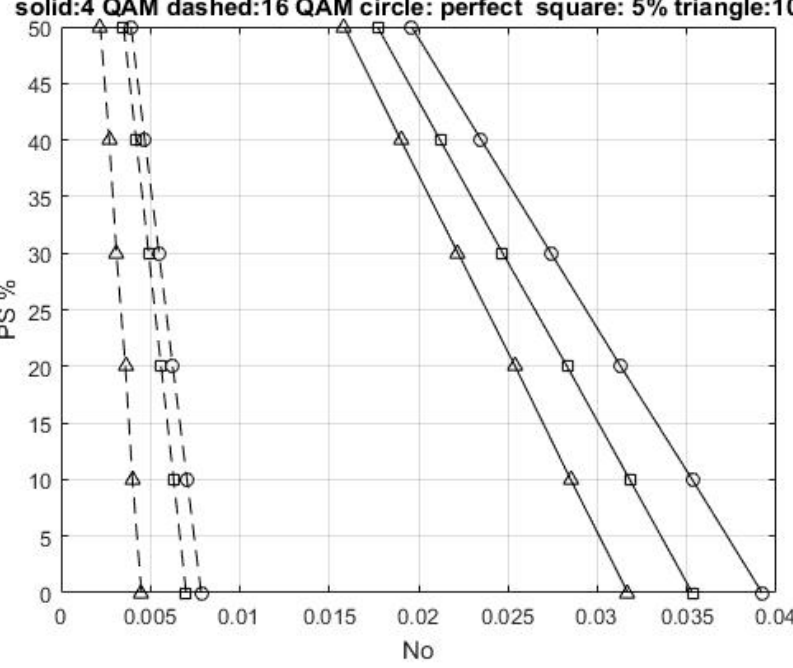
Figure 4. Power saving ratio of the UFMC-based underwater transceiver with an LDPC code and a BER of 4 104 − × , for PCE and CEEs of 5% and 10%.